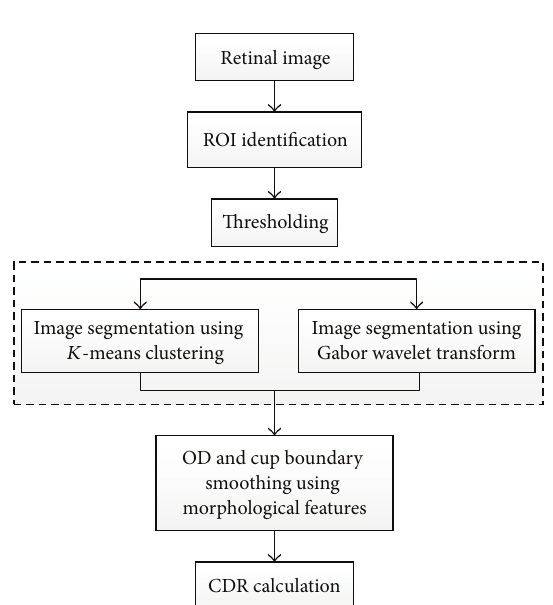
Figure 35: Flowchart for algorithm proposed in [65].